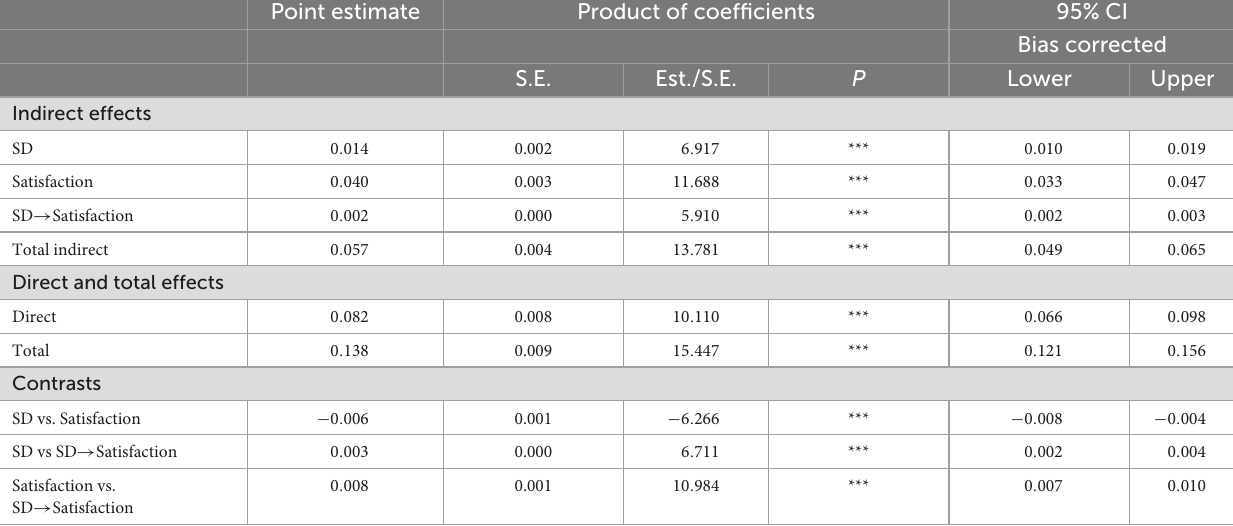
TABLE 6 Total, direct, and indirect effects of ACEs on CES-D, sleep duration and life satisfaction as mediators. Point estimate Product of coefficients